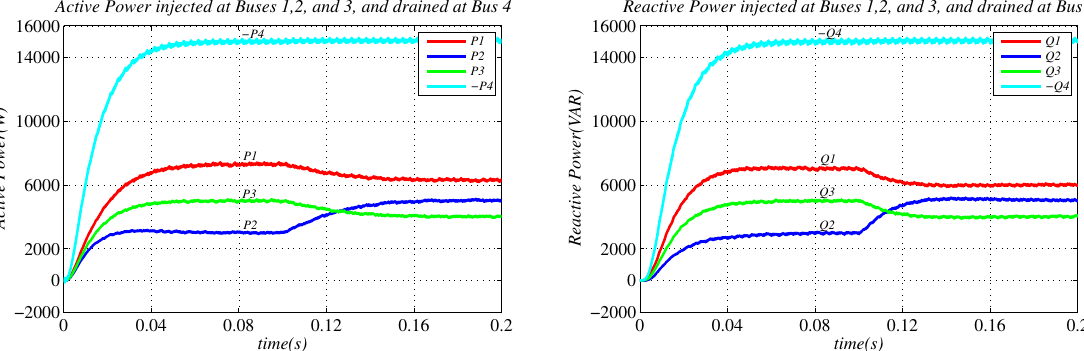
Figure 19. Active power and reactive power injected at Buses 1, 2, and 3 with the nonlinear load, and drained at Bus 4.